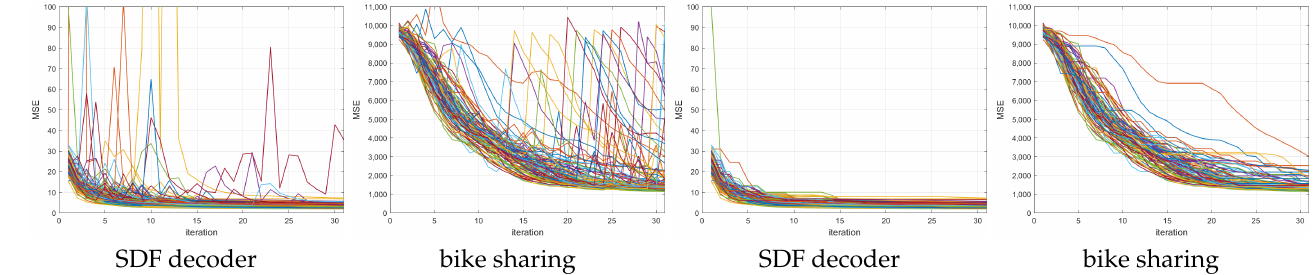
Figure 9. MSE plots vs. time (seconds) of 100 runs of training a 64 hidden-node NN using 30 iterations of ANMIN (Algorithm 1), with the different runs shown in different colors. Left two plots: the actual MSE values encountered at each iteration. Right two plots: the minimum MSE obtained so far at each